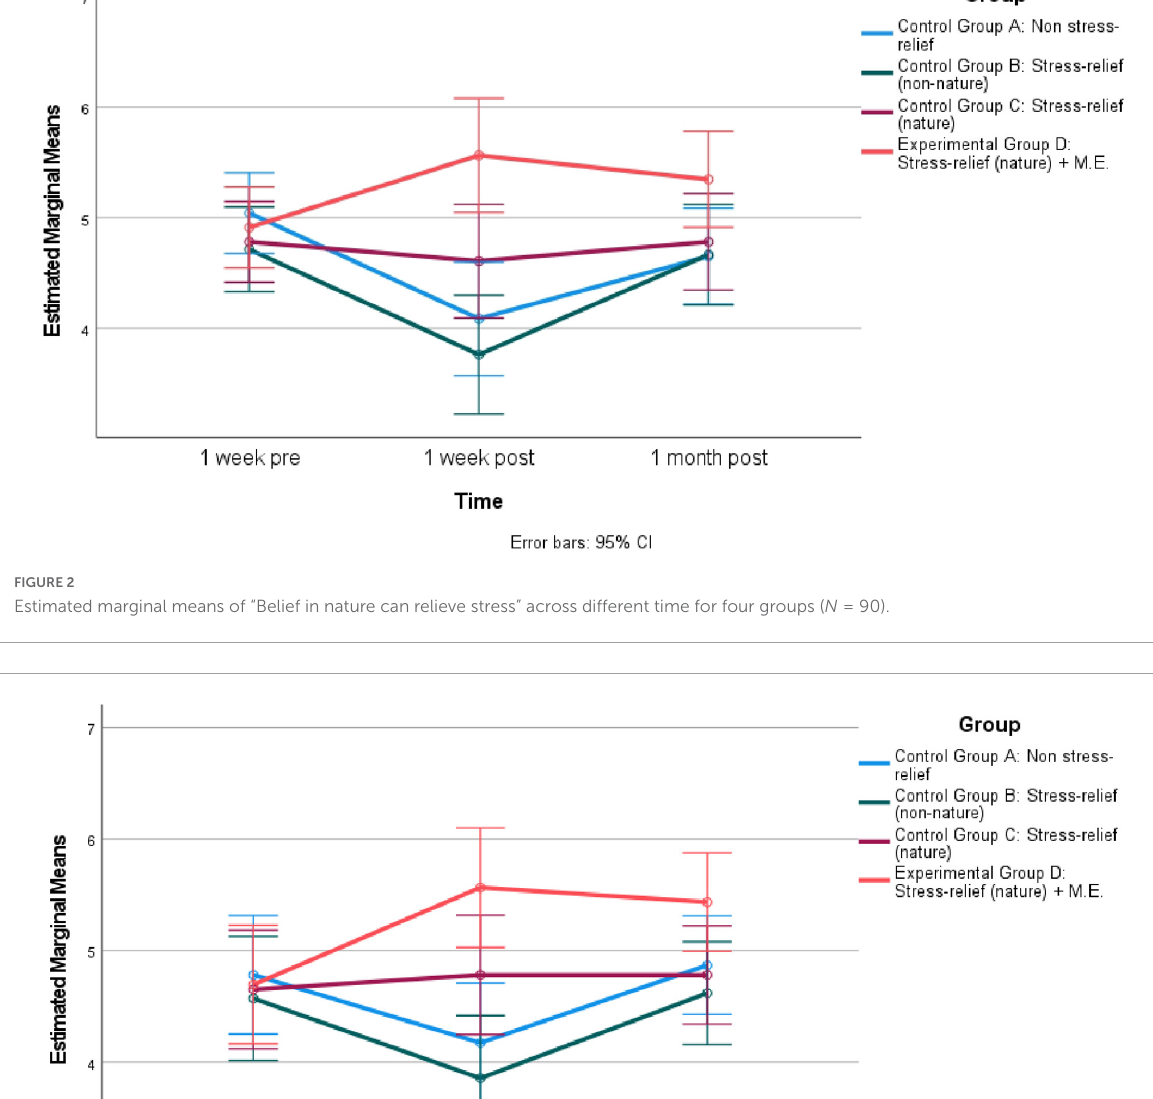
significantly lower than “Non-stress-relief” Group ( M = 3.79, SD = 1.09) and “Stress-relief (non-nature)” Group ( M = 3.96, SD = 0.97). However, the significant differences among the groups no longer existed at 1 month post. For “Frequency of exposure to virtual nature for at least 20 min in last week at